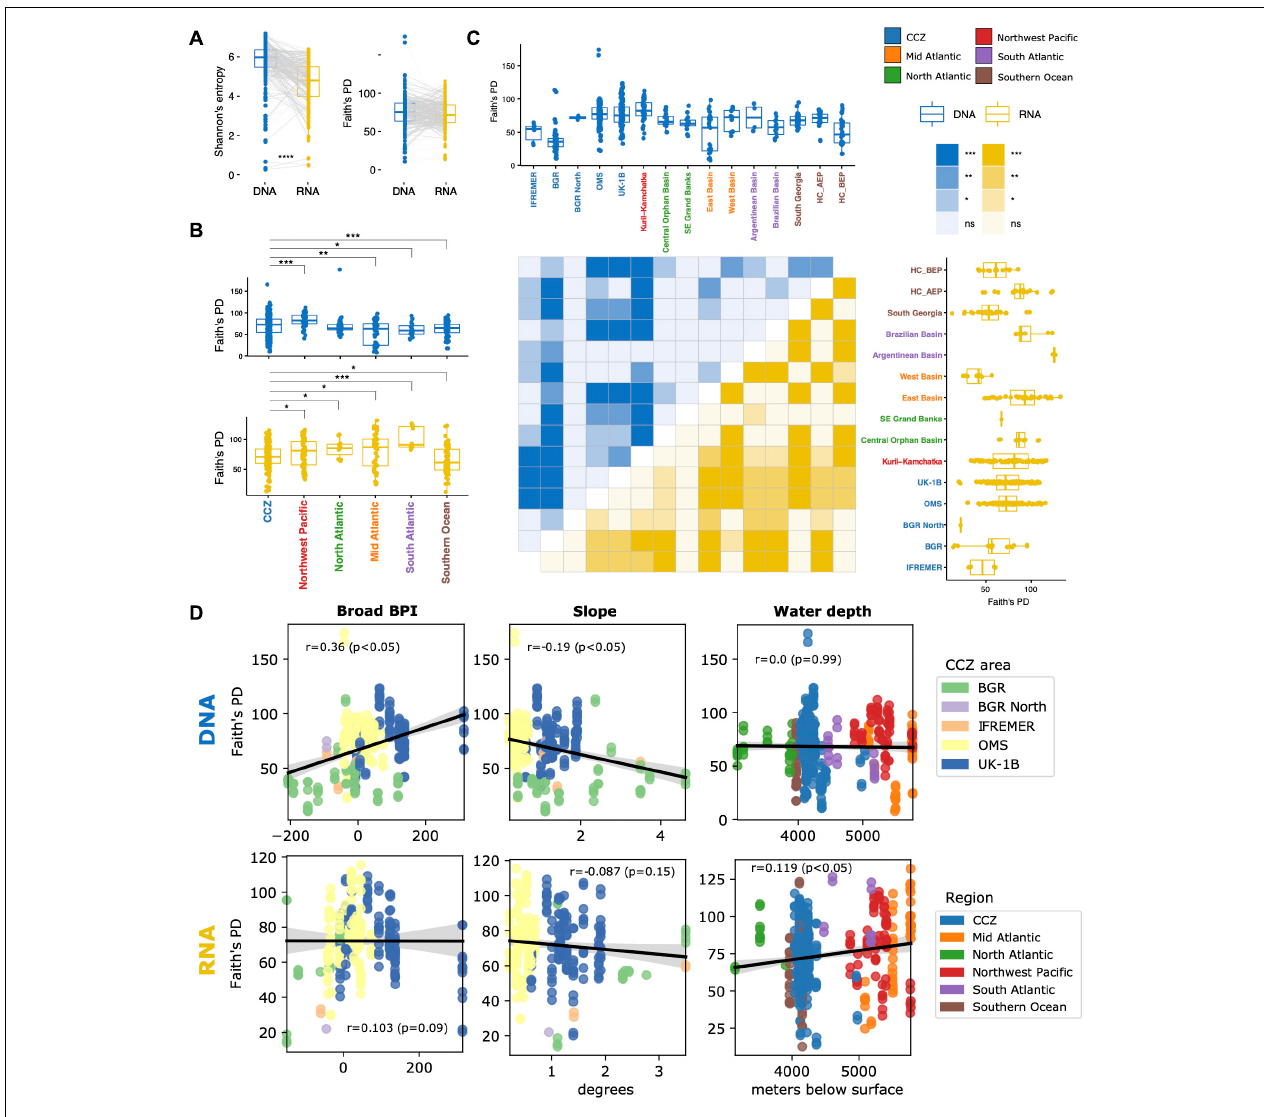
FIGURE 6 | Alpha diversity comparisons between molecules, regions and areas, and correlations with environmental variables for the Foraminifera dataset. (A) Paired Kruskal–Wallis test between DNA and RNA alpha diversity indices within the CCZ. Gray lines indicate same-sample paired comparisons. Pairwise post hoc tests separately for the DNA and RNA samples to compare the Faith’s PD alpha diversity between individual regions (B) and areas (C) . Significant differences between regions are shown using box-to-box connectors (B) whereas for areas, these are indicated in the heatmaps (blue triangle: within-DNA comparisons; yellow triangle: within-RNA comparisons). (D) Spearman correlations between the Faith’s PD alpha diversity of DNA or RNA samples and environmental variables in the CCZ. Slope and Broad BPI are only available for the CCZ region whereas water depth is shown across regions. Spearman’s rho statistics and p -values are indicated on insets. *** p -value ≤ 0.01; ** p -value ≤ 0.03; * p -value ≤ 0.05; no label/ns: p -values > 0.05; no color (heat map): no testing. Results for the V1V2 dataset are shown in Supplementary Figure 15